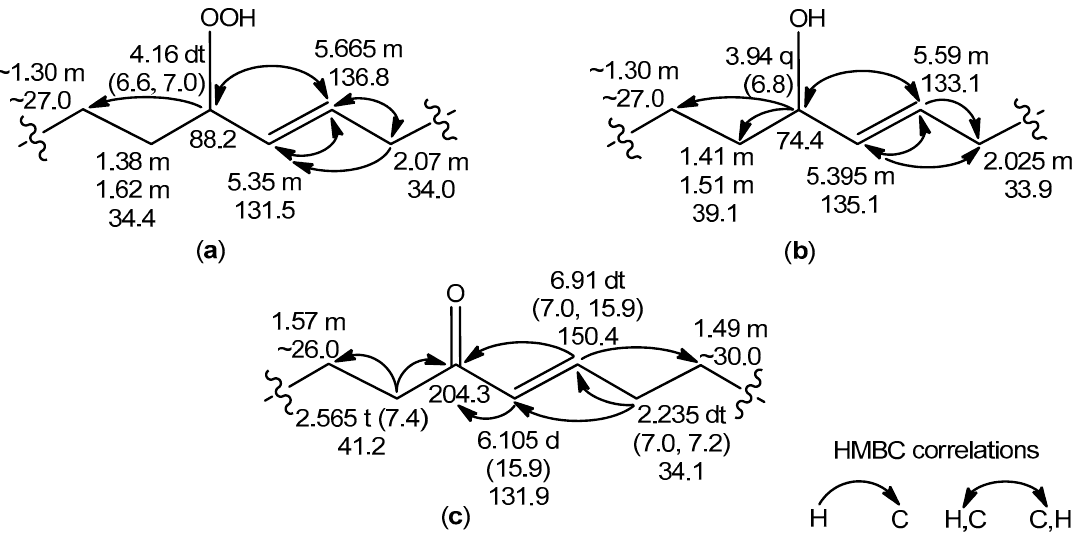
Figure 5. The δ H (500 MHz) and δ C (125 MHz) values and key HMBC correlations for acyl fragments with allylic ( a ) hydroperoxy (acyl chains a – d ), ( b ) hydroxy (acyl chains a / – d / ), and ( c ) keto (acyl chains a // – d // ) groups (solvent: CD 3 OD).